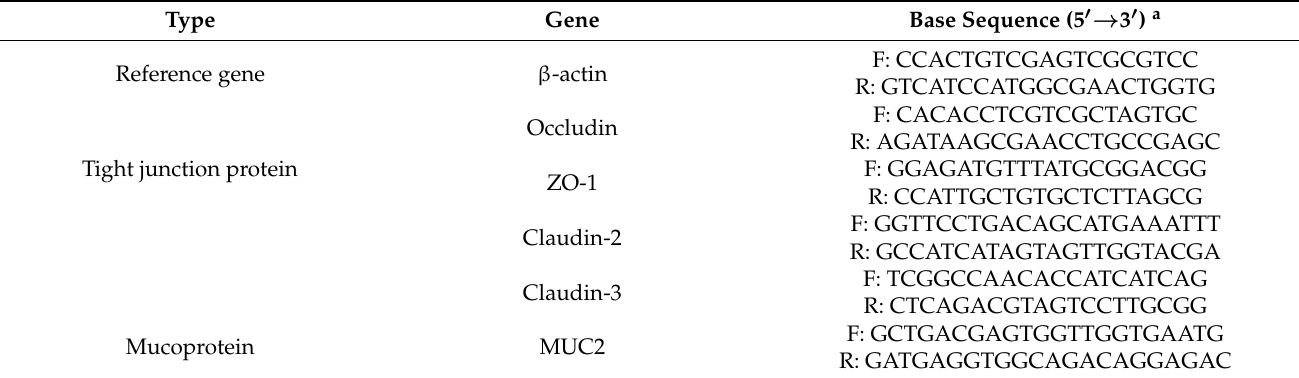
Table 1. The specific RT-qPCR primers for target